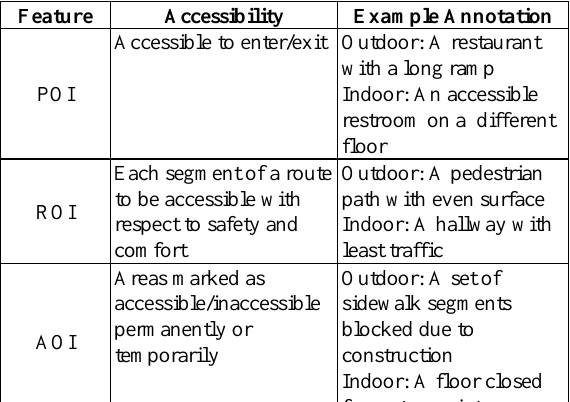
Table 1. Wayfinding features and annotation in SoNavNet.